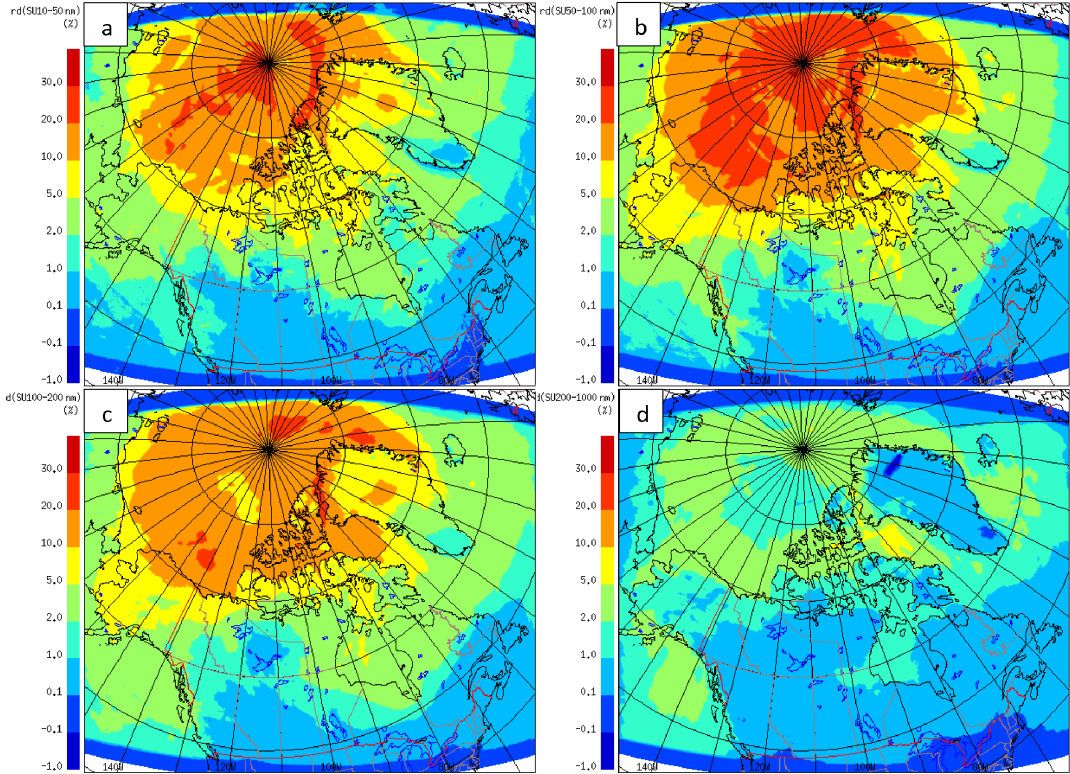
Figure 17. The relative difference of aerosol in the (a) 10–50nm, (b) 50–100nm, (c) 100–200nm and (d) 200nm–1µm size ranges, with and without the 75% yield of SO 2 from the OH-addition pathway for July